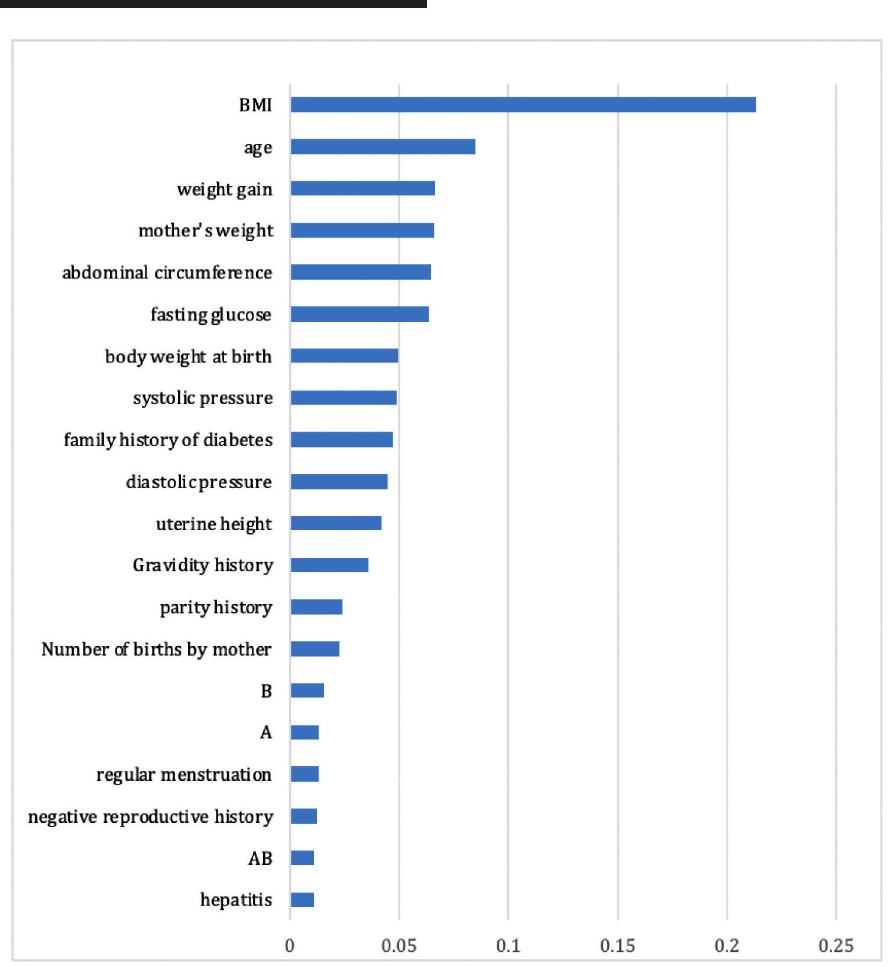
Figure 7. Weighted ranking in the F3 model (top